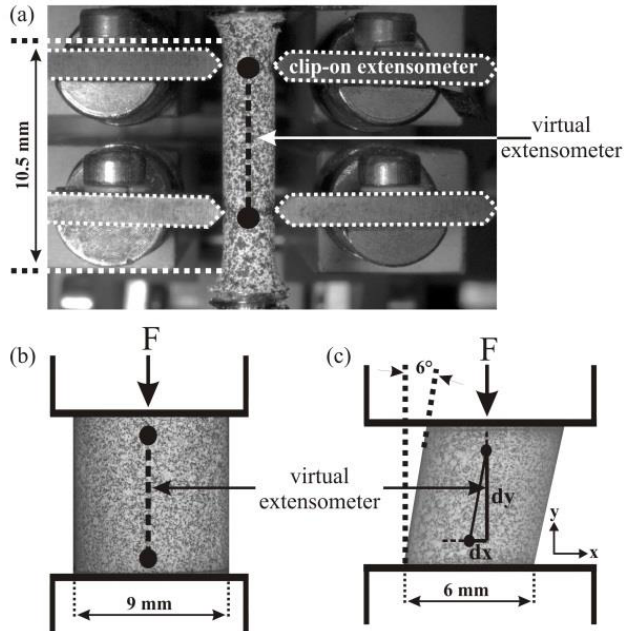
Figure 1. Geometries of the samples used for the mechanical testing and artificially-produced speckle patterns on the samples required for the measurement of the surface strain fields using digital image correlation (DIC): ( a ) cylindrical dog-bone-shaped tensile test sample; ( b ) cylindrical compression test sample; ( c ) cylindrical compression-shear test sample with an inclination angle of 6° that results in superimposed shear stresses during compressive loading. The conventional clip-on extensometer for tensile testing (indicated in ( a )) and virtual extensometers used for the deformation measurements in all our mechanical tests are shown schematically on the specimen surfaces. In tensile, compression, and also in compression-shear tests, the uniaxial strain was determined from the DIC images by considering two surface points (black dots) and their relative displacements in the axial direction, dy ; positioning of these points was varied in post-experimental analysis.